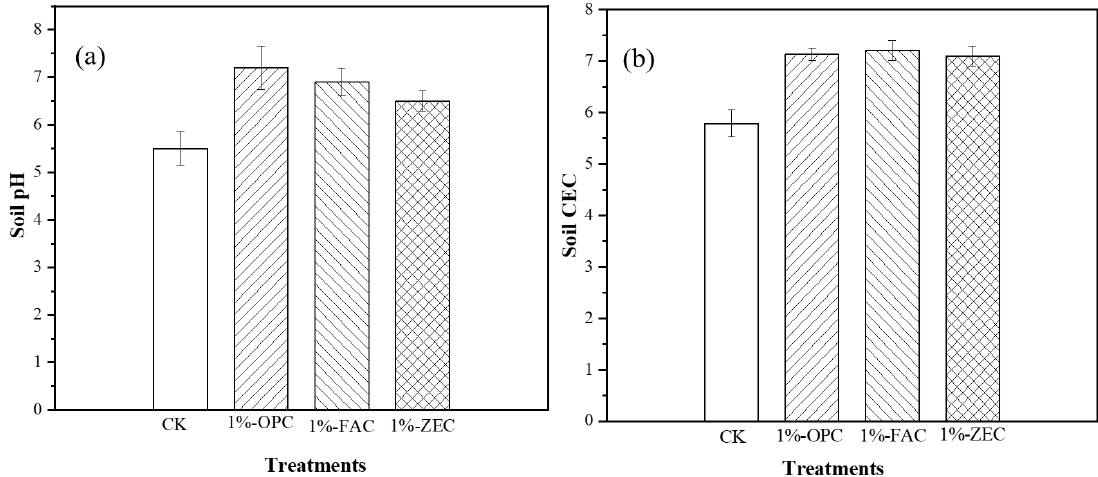
Figure 4. The changes of soil pH and CEC after treatment with amendments. Notes: ( a ) The changes of soil pH after treatment with 4 amendments; ( b ) The changes of soil CEC after treatment with 4 amendments. Treatments: control (CK), OPC paste, FAC paste, and ZEC paste.